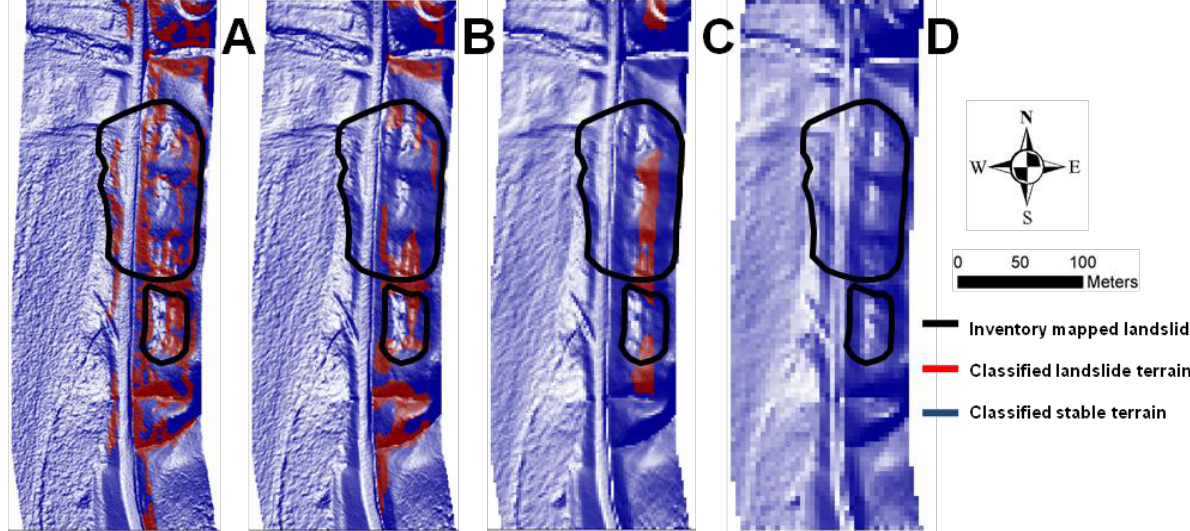
Figure 4. Classification using the SVM algorithm with 50 (A), 100 (B), 200 (C), and 400 (D) cm spatial resolution.